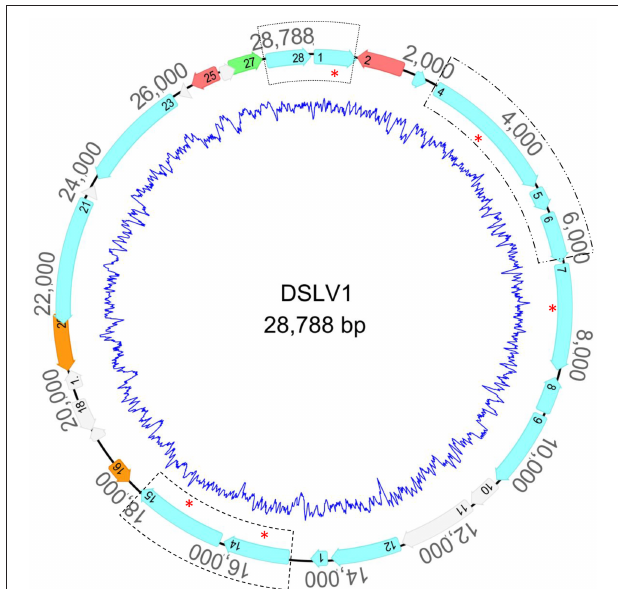
FIGURE 3 | Circular map of the complete genome of DSLV1. Homologous genes shared between DSLV1 and YSLV3 are labeled in light blue; DSLV1 and giant algal viruses in red; DSLV1 and cellular organisms in orange; DSLV1 and PgVV ( Phaeocystis globosa virus 16T virophage) in green. ORFans are marked in light gray. The interior blue line represents %G + C skew throughout the genome. Three gene clusters that have conserved synteny with other virophages are highlighted by the hashed rectangles. Red asterisks indicate the five conserved virophage genes. HEL, ATPase, PRO, MCP, and